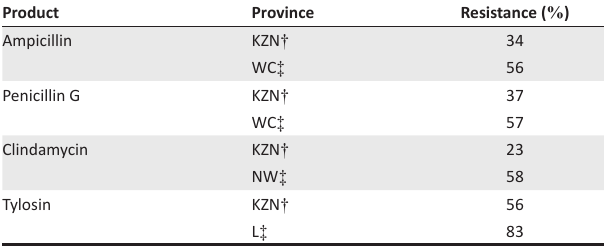
TABLE 2: Prediction of expectation of Staphylococcus aureus antibiotic resistance to ampicillin, penicillin G, clindamycin and tylosin for the provinces showing significant differences according to the general linear mixed